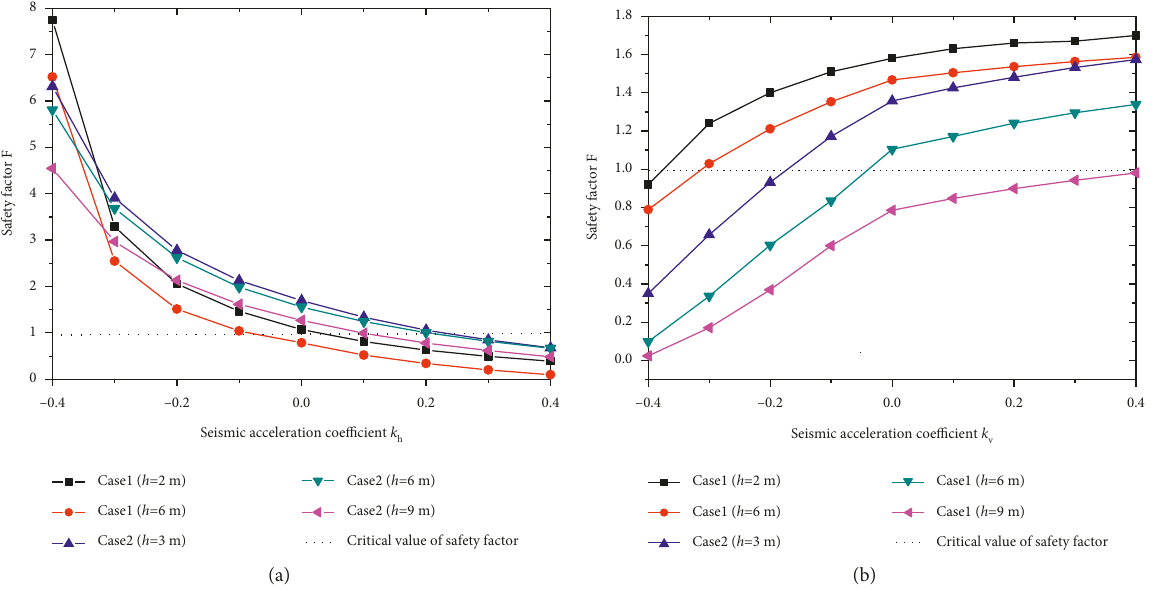
Figure 9: Effect of seismic acceleration coefficient on safety factor. (a) Horizontal seismic acceleration coefficient with safety factor. (b) Horizontal seismic acceleration coefficient with safety